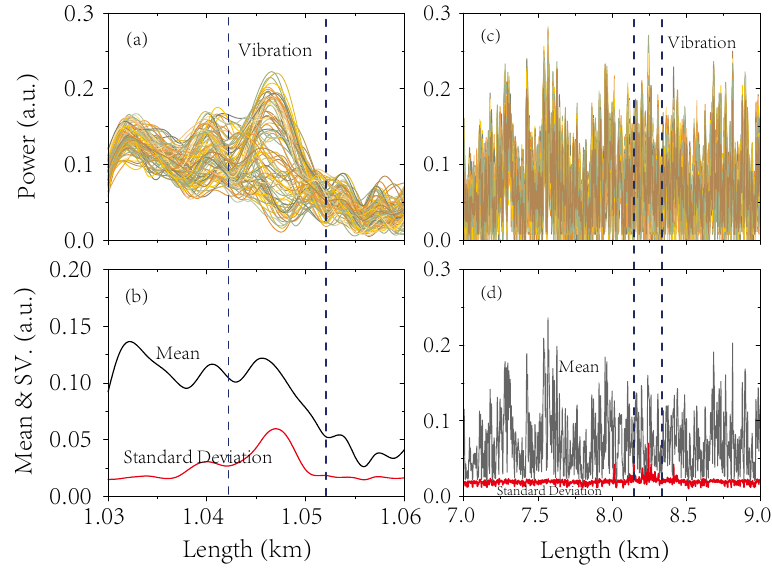
Figure 2. ( a ) Superimposition of 80 raw backscattered traces with PZT modulation at 1 km; ( b ) mean and standard variance of ( a ); ( c ) superimposition of 100 raw traces with a running vehicle at 8.2 km; ( d ) mean and standard variance of ( c ).